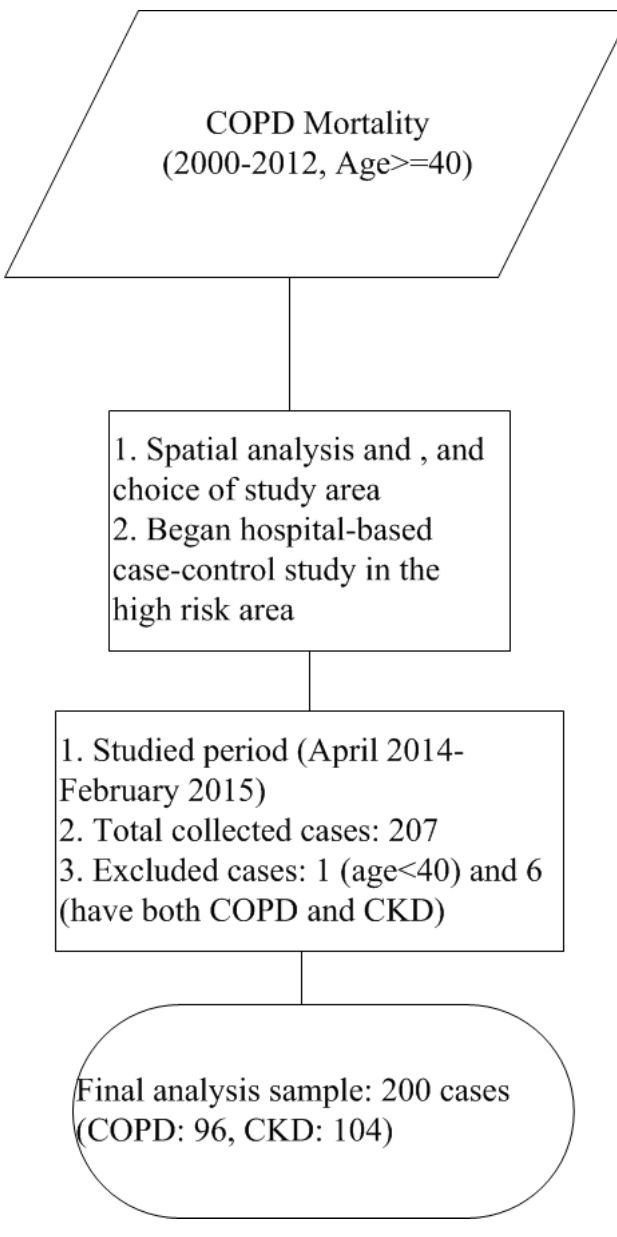
Figure 3. Recruitment flow chart